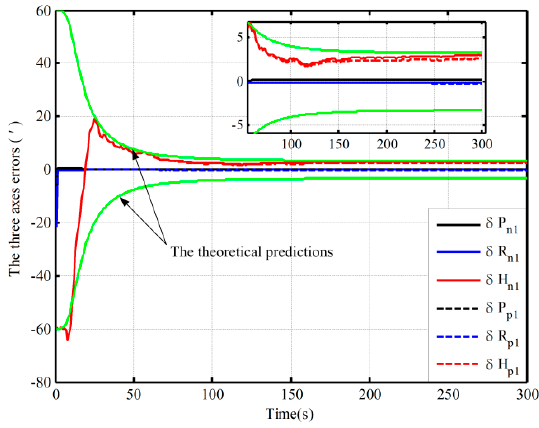
Figure 3. The open-loop alignment simulation results in Case 1.